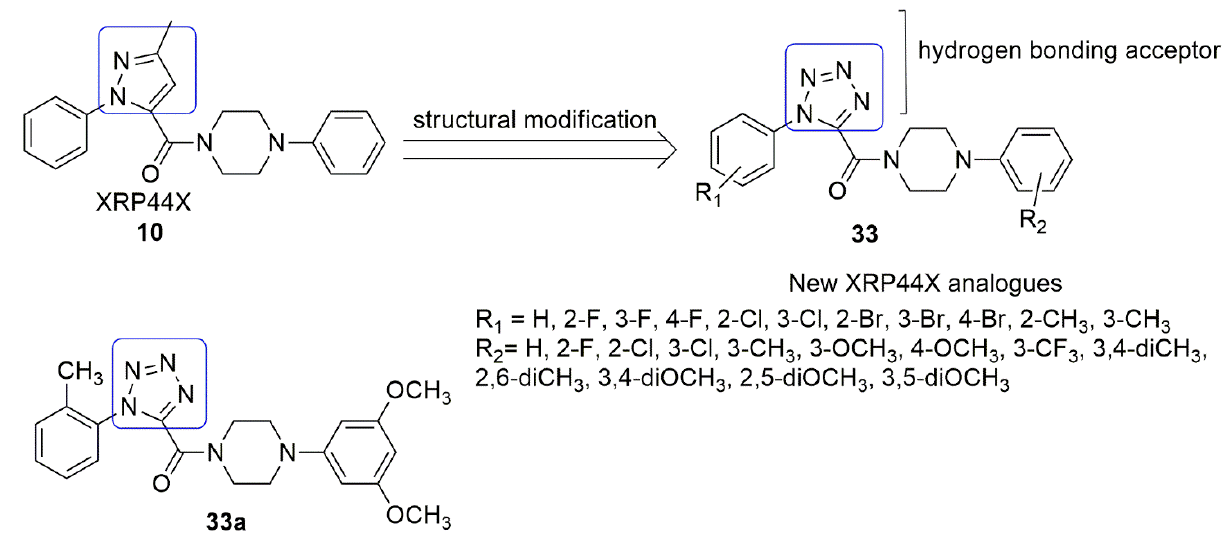
Figure 13. Chemical structures of 1-aryl-5-(4-arylpiperazine-1-carbonyl)-1 H -tetrazole derivative as microtubule destabi- lizers. microtubule